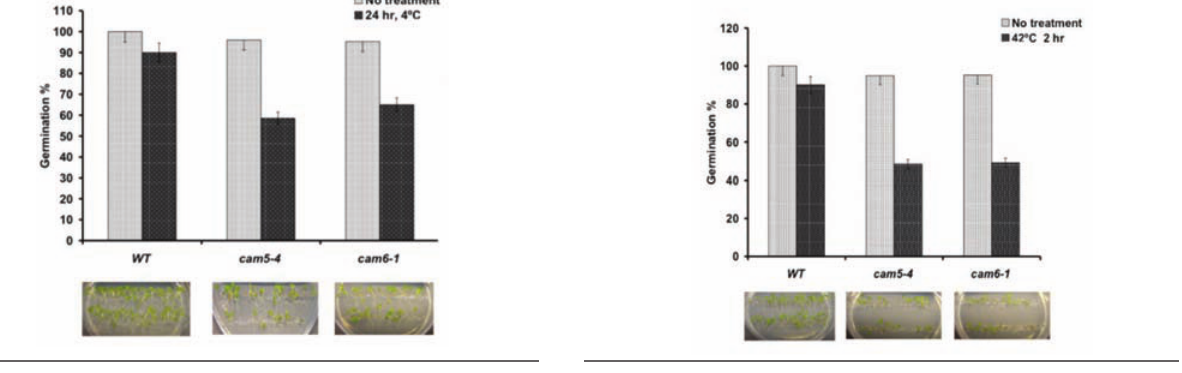
Figure 1. Germination of seeds of wild type, cam5-4 , and cam6-1 Figure 2. Germination of A. thaliana seeds of wild type and T- mutants of A. thaliana after exposure to 4°C for 24 hours. Fifty DNA insertion mutant alleles cam5-4 and cam6-1 after exposure seeds each of the wild type and cam mutants were surface steril- to 42°C temperature. Fifty seeds each of genotype were surface ized and exposed to 4ºC for 24 hours. Treated seeds were plated sterilized and exposed to 42ºC for 2 hours. Heat treated and con- on MS salt-agar medium and allowed to germinate at 25°C under trol seeds were allowed to germinate described in Materials and continuous light for seven days. The percent of germinating seeds Methods. The number of germinating seeds was scored. Error were scored. Error bars represent standard deviation over three bars represent the standard deviation over three replicate replicate plates. Except for cam5-4 and cam6-1, all cam mutants showed germination of seeds comparable to wild type. Table 5. The level of gamma-aminobutyric acid, alanine and glutamate in root and shoot tissues of two week old seedlings of wild type and cam mutants of A. thaliana was determined after exposure to various cold treatments at 4ºC as indicated in material and method.